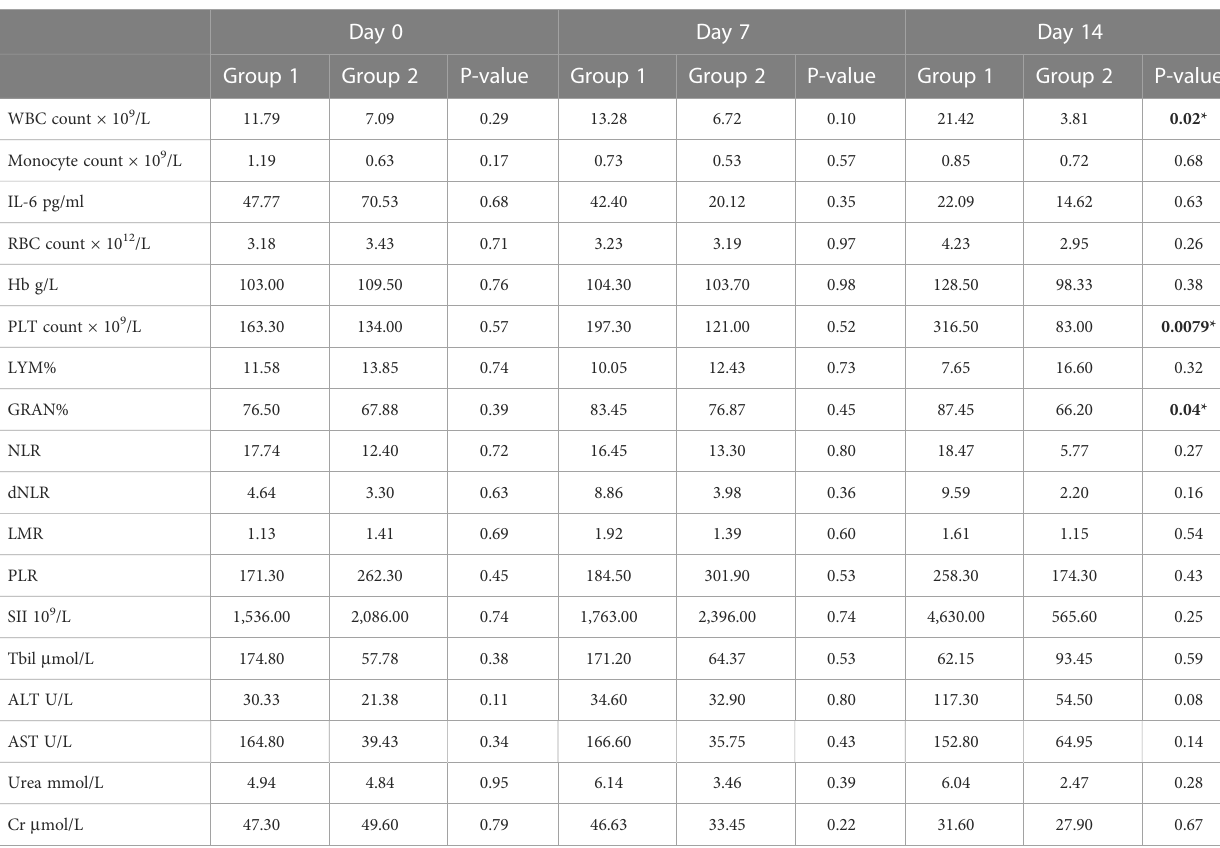
TABLE 4 Study timepoint analysis of clinical data between cancer patients with Omicron infection and cancer patients without Omicron infection across the three study